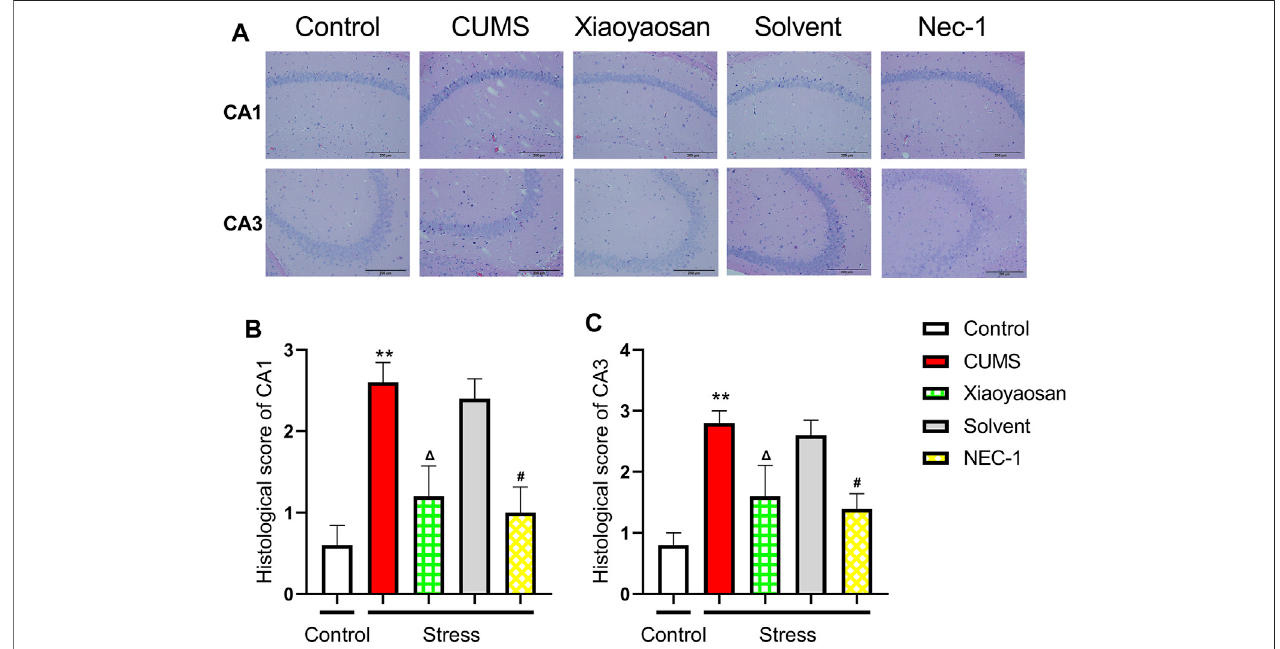
FIGURE 9 | The histological changes in CA1 and CA3 regions of the hippocampi in CUMS mice (A) Representative micrographs of H&E staining (scale bar (cid:1) 200 μ m, × 400 magni fi cation) in the CA1 and CA3 regions (B) The histological scores in the CA1 region (n (cid:1) 5) (C) The histological scores in the CA1 region (n (cid:1) 5). Data were expressed as means ± SEM, ** p < 0.01 versus control group; Δ p < 0.05 versus CUMS group; # p < 0.05 versus Solvent